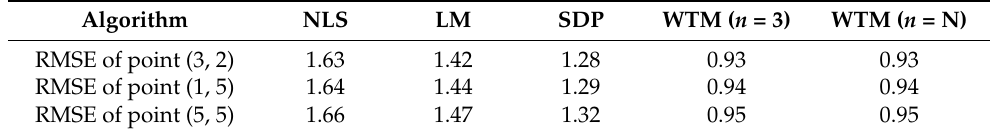
Table 4. Localization results for NLS, LM, SDP and WTM based on measured RSSI data for three selected